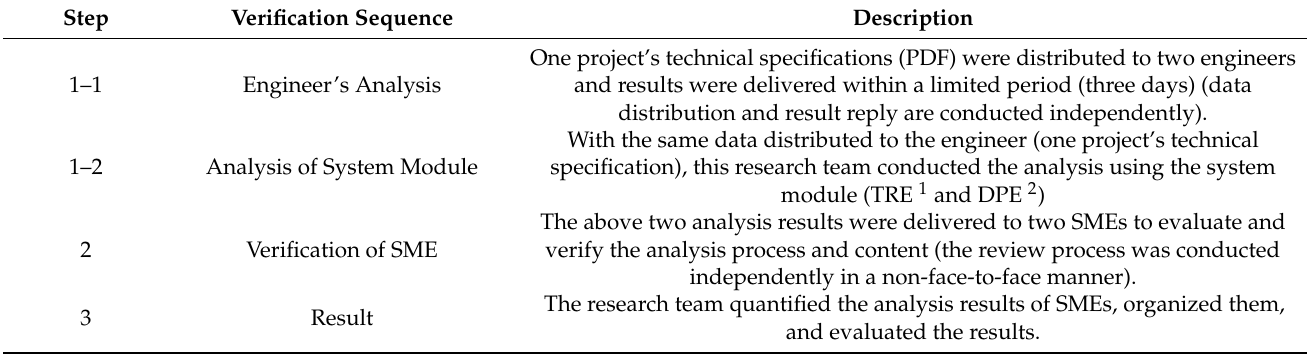
Table 7. Description of verification for technical specification analysis